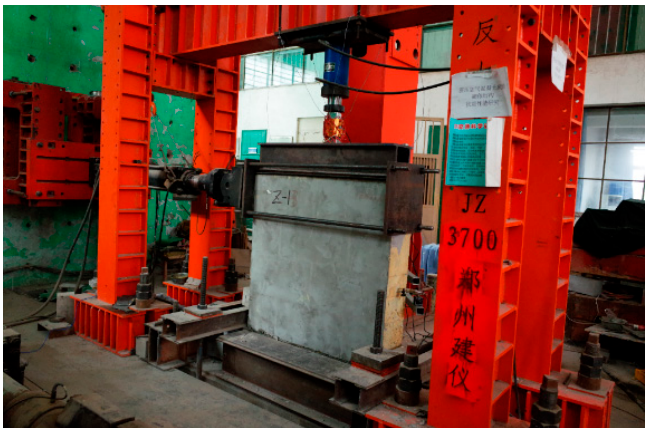
Figure 2. Scene photos of test devices and wall specimen.